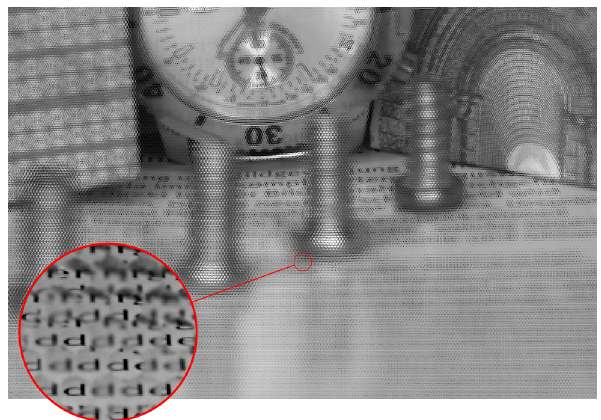
Figure 9. Raw image recorded by a focused plenoptic camera. Dif- ferent to a regular camera, a plenoptic camera has a micro lens ar- ray (MLA) placed in front of the sensor (see Fig. 8). Therefore, the raw image recorded by the camera is not one consistent central per- spective image, but consists of thousands of circular micro images where each micro images shows only a small portion of the com- plete scene, as can be seen in the figure. From the magnified sec- tion, one can see that the same object point is projected to multiple neighboring micro images.